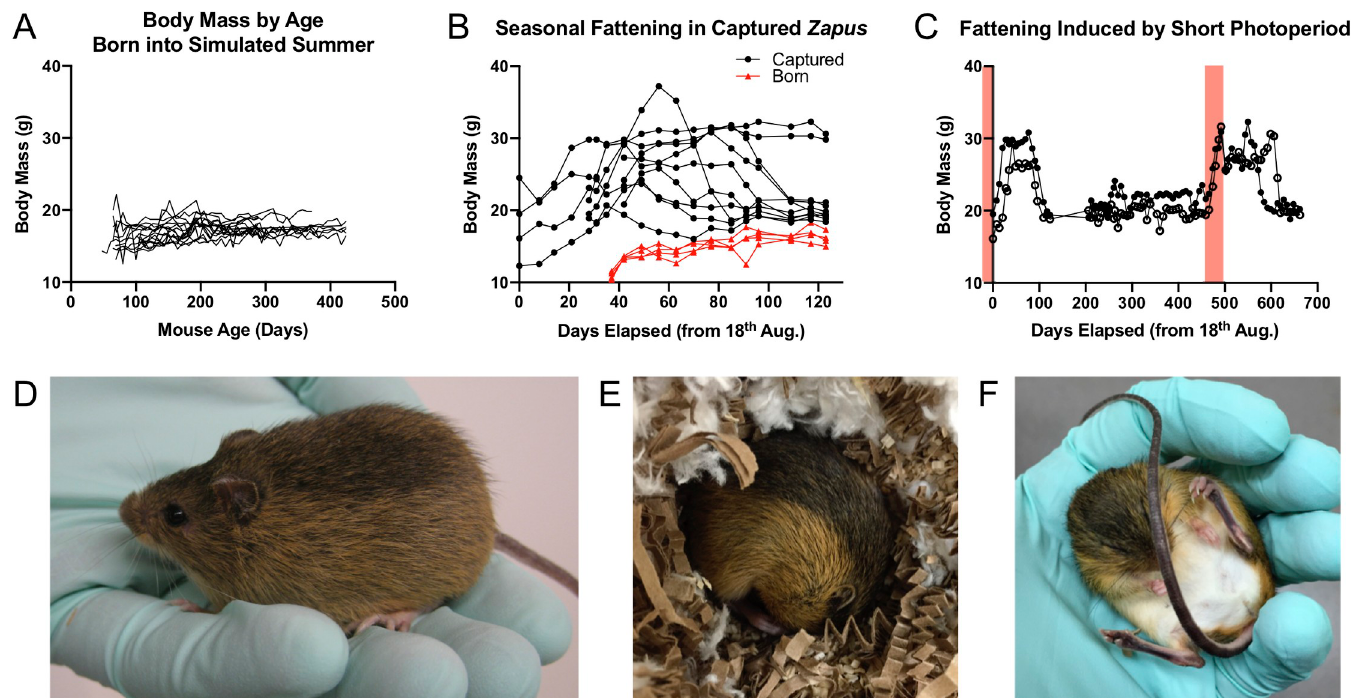
Fig 3. Photoperiod controls pre-hibernation fattening in wild-caught and captive-reared meadow jumping mice. ( A ) Body mass by age of 15 captive-born meadow jumping mice that were housed under long photoperiod (16L:8D) which inhibited pre-hibernation fattening. ( B ) Body mass of animals captured near the end of the active season (black lines, circles, n = 10) or born to a female that was pregnant while captured (red lines, triangles, n = 4) and held at long photoperiod (16L:8D). Animals captured at the end of summer fattened for hibernation despite the long photoperiod; captive-born animals did not fatten. ( C ) Periods of exposure to short photoperiod (12L:12D, shaded red) are sufficient to induce pre-hibernation fattening in animals that were held at long (16L:8D) photoperiod after capture. ( D ) A meadow jumping mouse that has prepared for hibernation by fattening. ( E ) A meadow jumping mouse curled up in typical posture used during torpor. The nest box lid and nest were opened to view the animal. ( F ) A partially uncurled animal that was found torpid at 20˚ C ambient temperature. Full arousal takes around 10 minutes at this temperature [24].